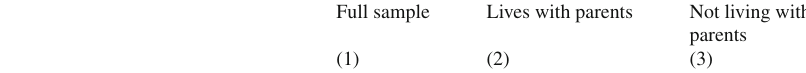
Table 1 Summary statistics. Source : Panel A: Spanish Labor Force Survey (EPA): 1995–2009 (cross- sectional version). See Table 12 for the definition of the concepts. Sample of male Spanish citizens that turn 25 in the year of the survey. Panel B: Spanish Labor Force Survey (EPA): 1993–2002 (longitudinal